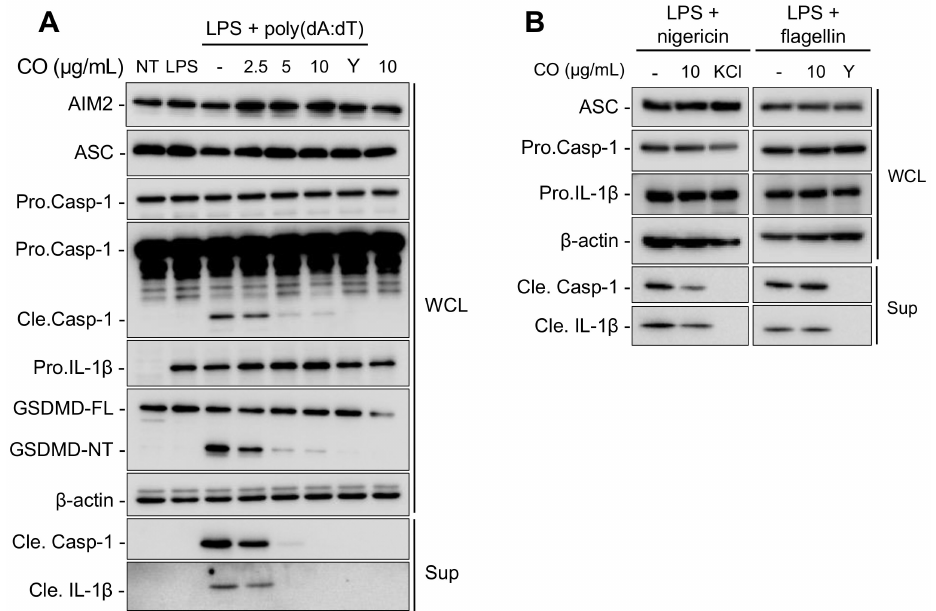
Figure 3. CO suppresses the release of IL-1 β through the inhibition of caspase-1 activation. Im- munoblotting analysis of culture supernatants (Sup) and whole cell lysates (WCL), with results shown for LPS (100 ng/mL)-primed BMDMs pre-treated with CO or 50 µ M YVAD (Y) at the in- dicated concentrations for 30 min followed by ( A ) poly(dA:dT) (1 µ g/mL) transfection for 2 h, ( B ) nigericin (10 µ M) treatment for 1 h, and flagellin (1 µ g/mL) transfection for 3